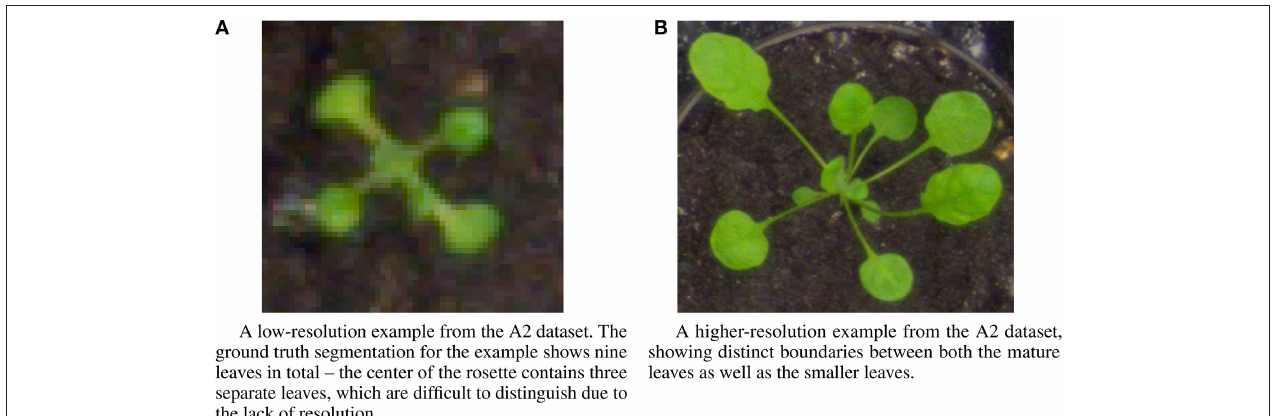
FIGURE 3 | Example images from the A2 dataset showing a range of diversity in image resolution, leaf size and shape, and leaf counts. (A) A low-resolution example from the A2 dataset. The ground truth segmentation for the example shows nine leaves in total—the center of the rosette contains three separate leaves, which are difficult to distinguish due to the lack of resolution. (B) A higher-resolution example from the A2 dataset, showing distinct boundaries between both the mature leaves as well as the smaller leaves.